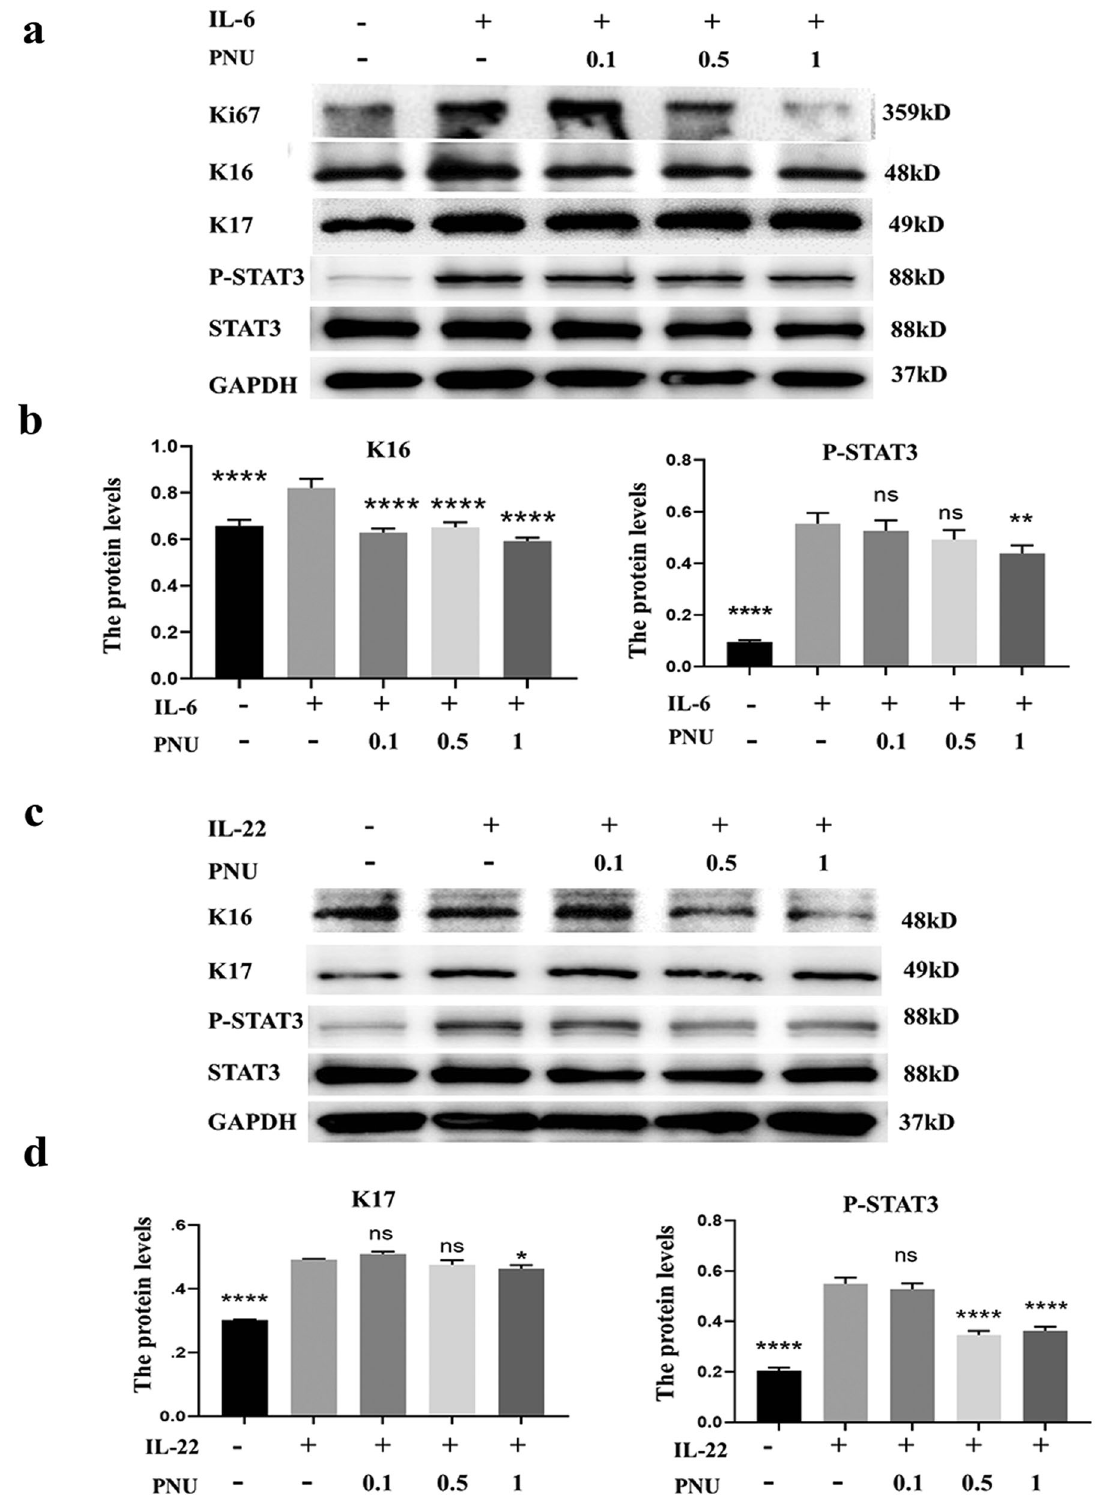
Fig. 4 PNU-282987 counteracts IL-6/IL-22 induced cutaneous in fl ammation and promotes differentiation by inhibiting STAT3 signaling pathway. a HaCaTs were pretreated with different concentrations of PNU-282987 (0.1 uM, 0.5 uM, 1 uM) for 12 h followed by stimulation of 25 ng/ml IL-6 or IL-22 for 30 min. The expression of Ki67, K16, K17, P-STAT3, and STAT3 were determined by western blot in response to IL-6 ( a ) or IL-22 ( c ) treatment. The values are normalized to GAPDH. The activation of STAT3 signaling pathway and its related proteins expression were quanti fi ed with the intensity of bands on Western blot by image J and Graphpad Prism software ( b , d ). * P < 0.05, ** P < 0.01, *** P < 0.001.